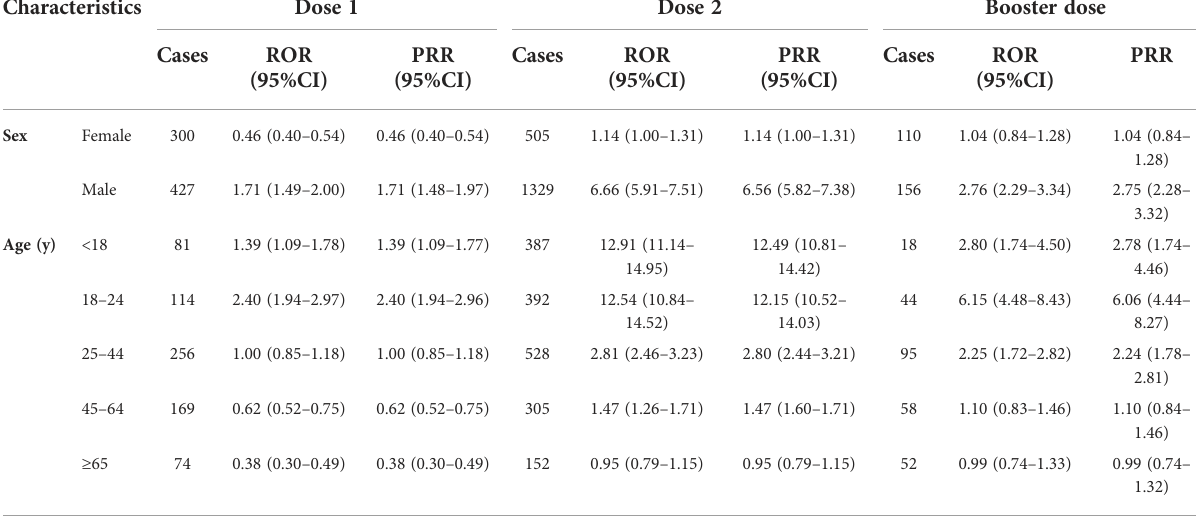
TABLE 5 Sub-group disproportionality analysis of myocarditis/pericarditis following mRNA COVID-19 vaccination compared to all other vaccines from VAERS by age, sex and dose.